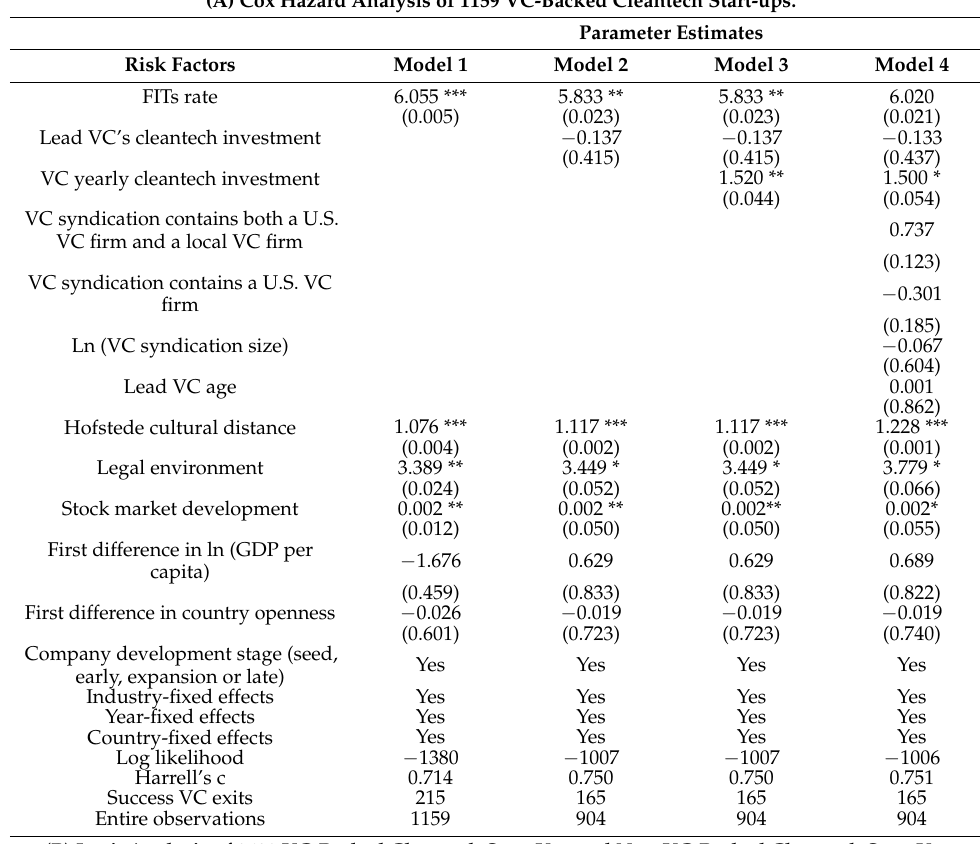
Table 3. Analysis of cleantech